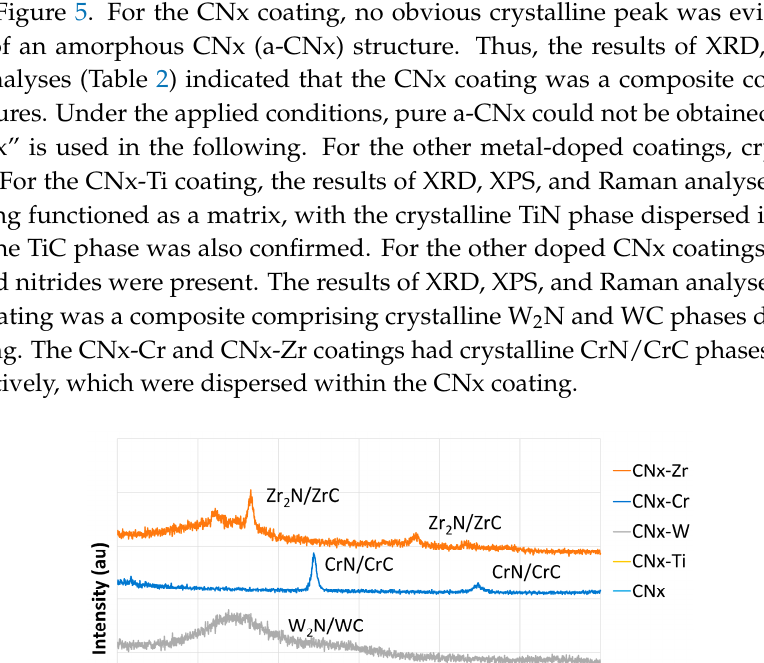
Figure 4. W4f XPS raw and deconvoluted spectra derived from bonding energy of CNx-W coating characterized by XPS.